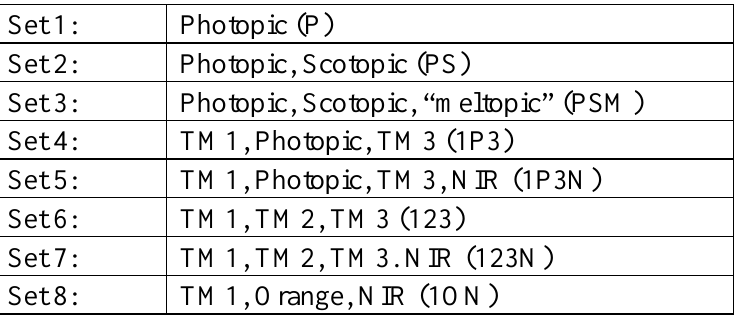
Table 2. Band combinations tested-with their abbreviations.